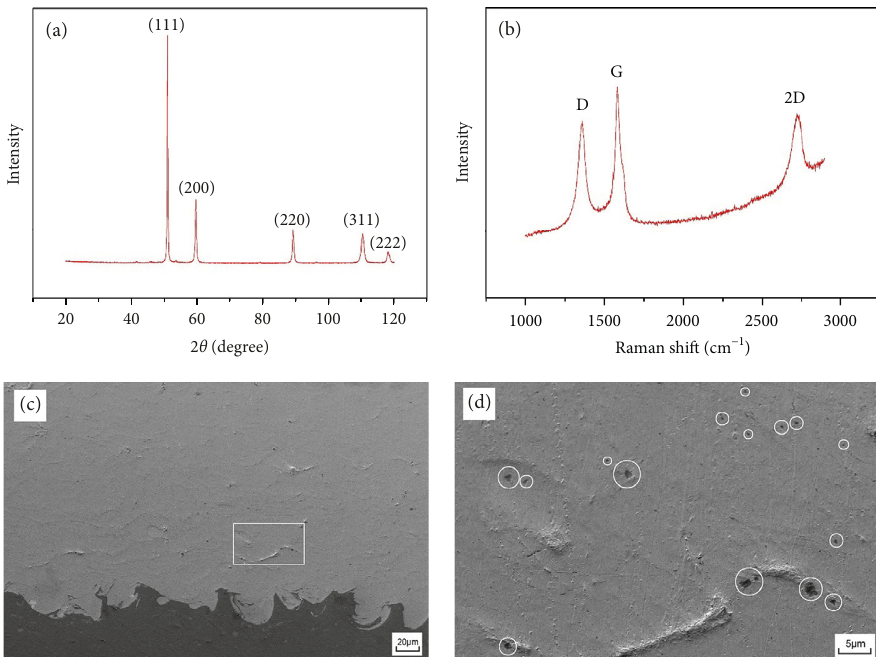
Figure 14: Characterization of graphene-Cu MMC coating produced using ball-milled powders: (a) XRD spectrum, (b) Raman spectrum, (c) coating cross-sectional view, and (d) a magnified view [32].